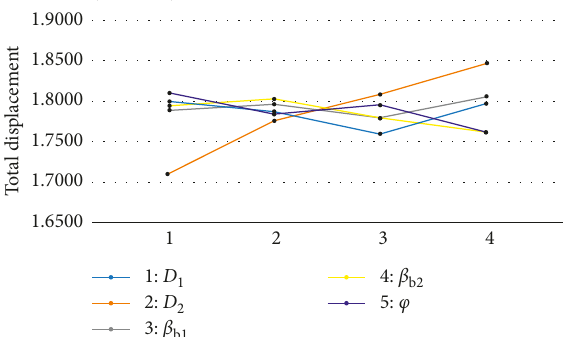
Table 9: Influence data of various factors on